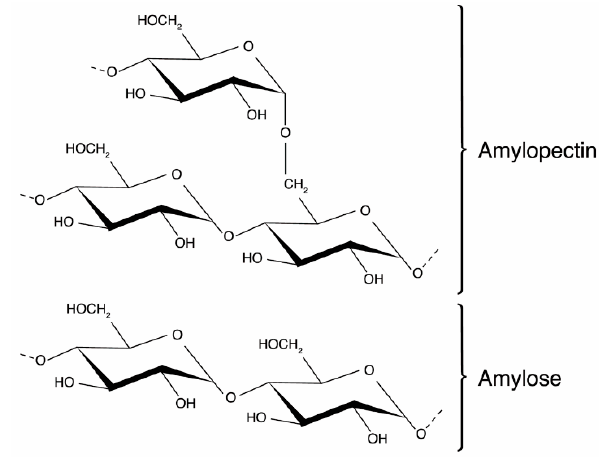
Figure 9. Chemical structure of starch polysaccharide.